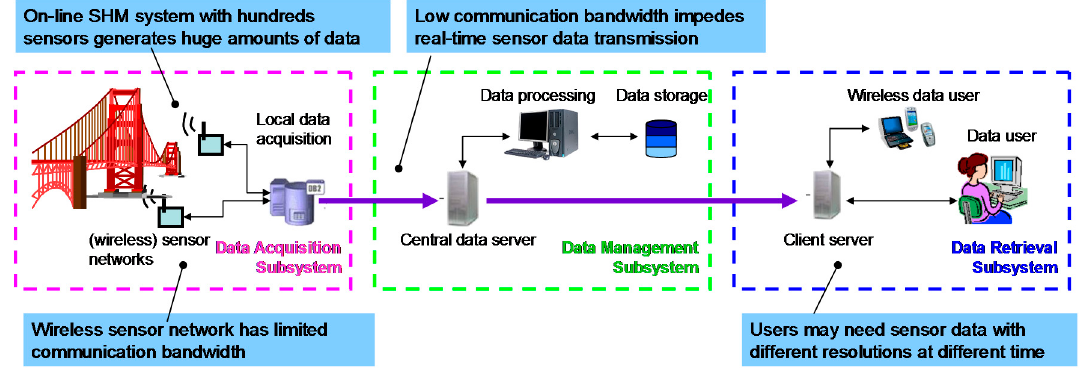
Figure 1. Schematics of an on-line structural health monitoring system and technical